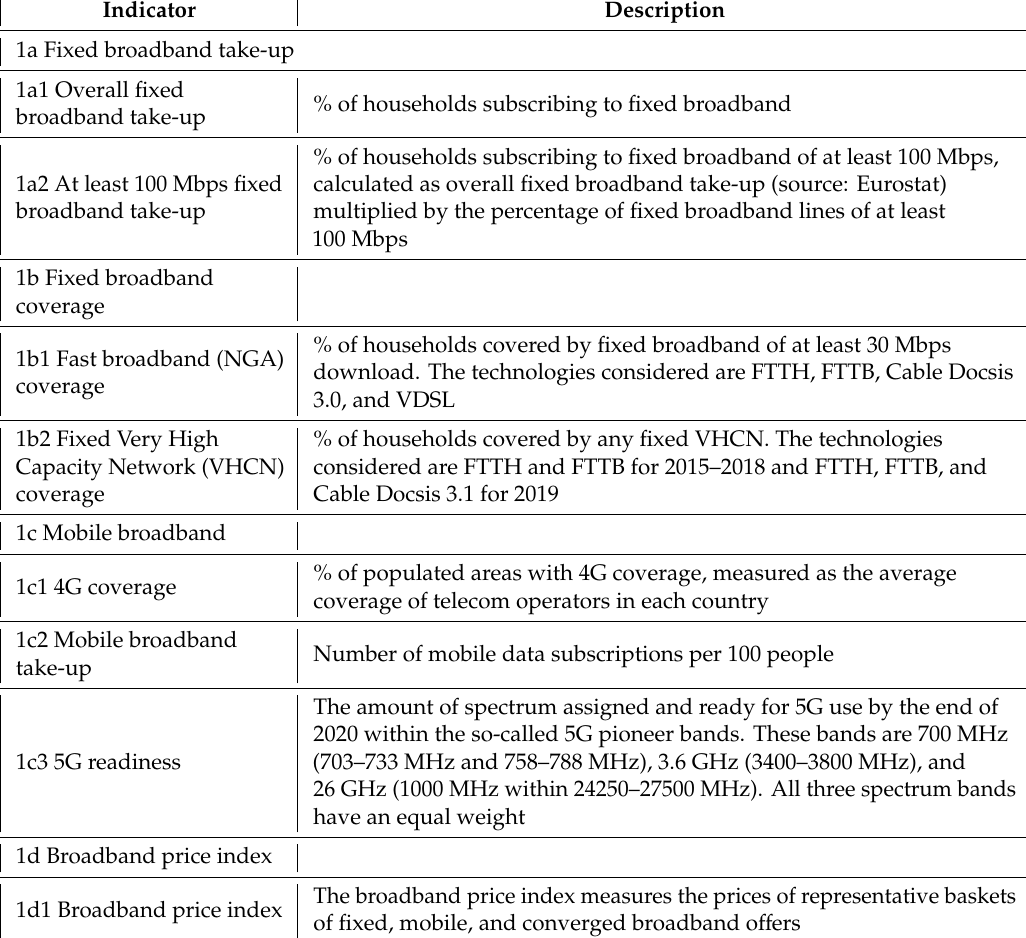
Table 1. A Connectivity Dimension in the Digital Economy and Society Index (DESI) Structure.